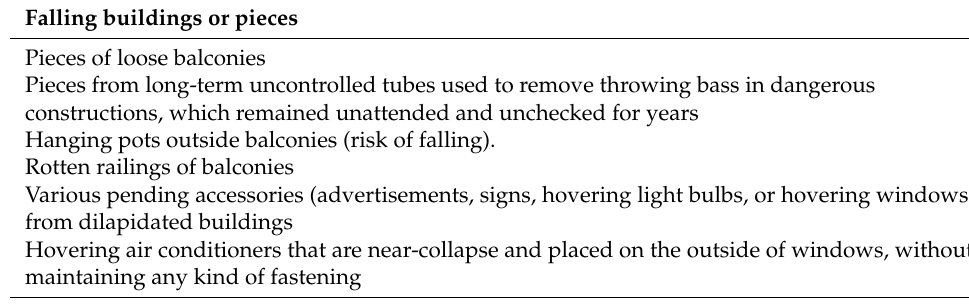
Table 1. Key findings of our case